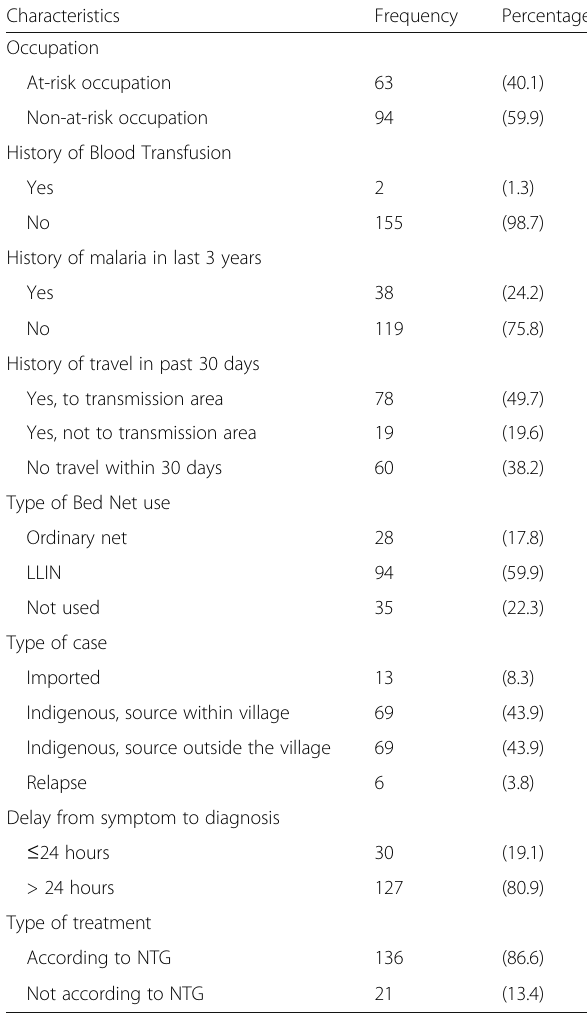
Table 2 Risk profile of investigated malaria cases during April- 2018 to March-2019 (N= 157)